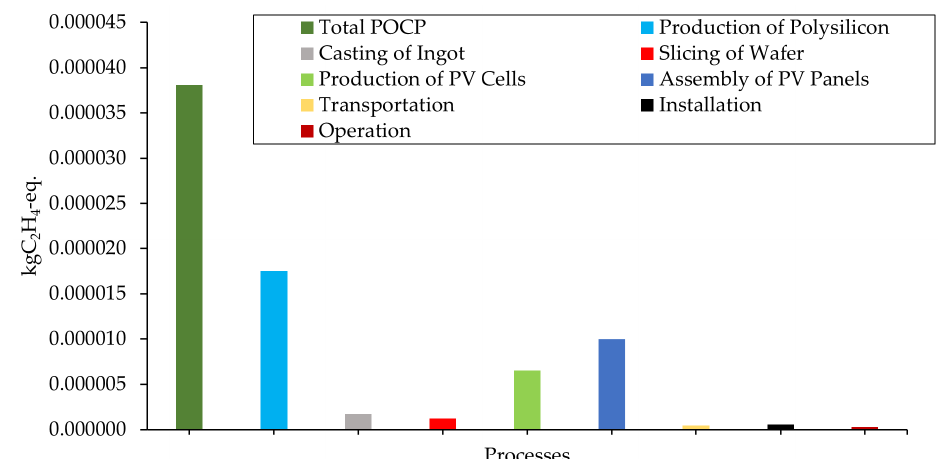
Figure 10. Photochemical ozone creation potential.